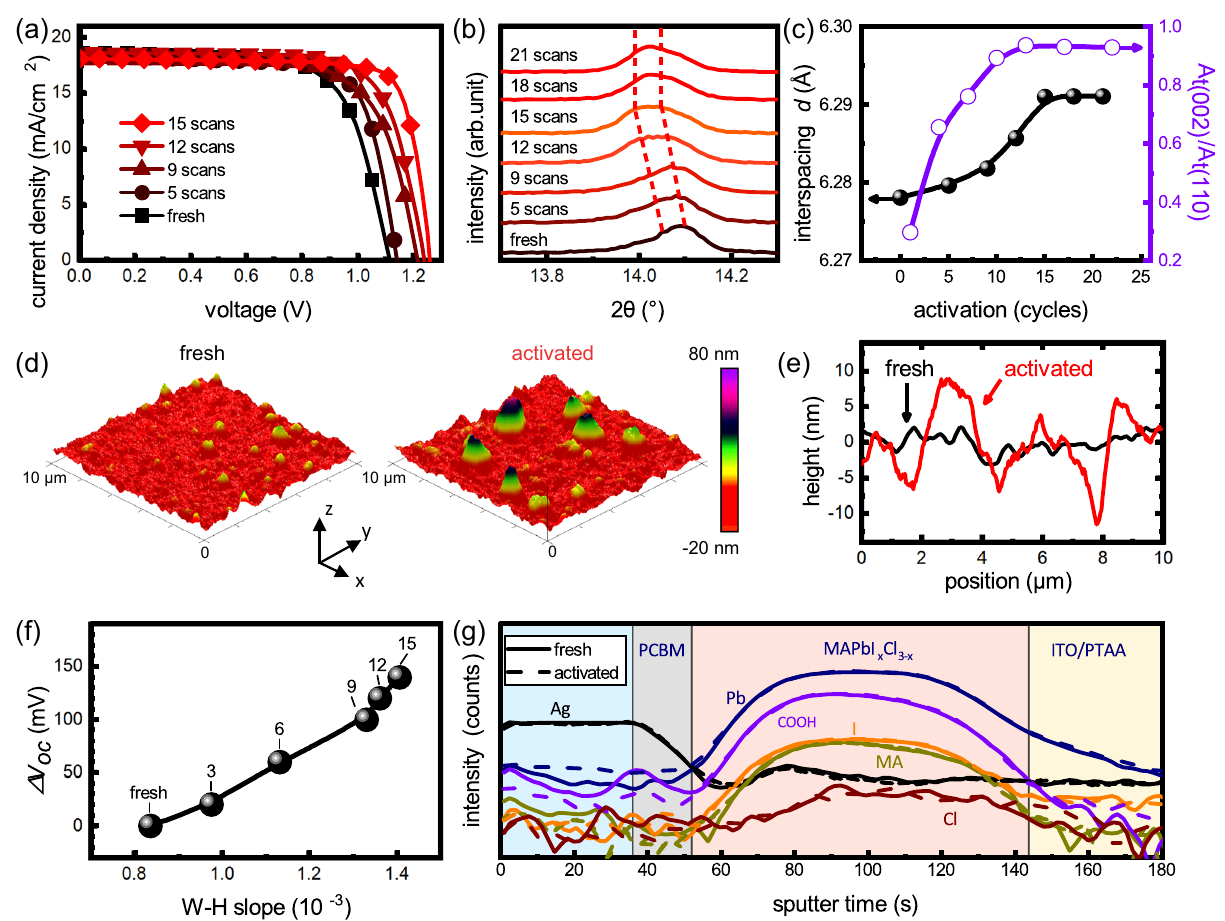
Fig.3 |FerroelasticdeformationoftT-phaseunderelectricactivation.a J-Vand b XRDoftT-phaseMAPbI x Cl 3-x solarcellsactivatedtodifferentlevels(from1.12Vto 1.26V). c interspacing of t(110) plane-set d (solid) and relative population of twin- domains A t(110) /A t(002) (open) versus activation cycles. d topography of fresh and